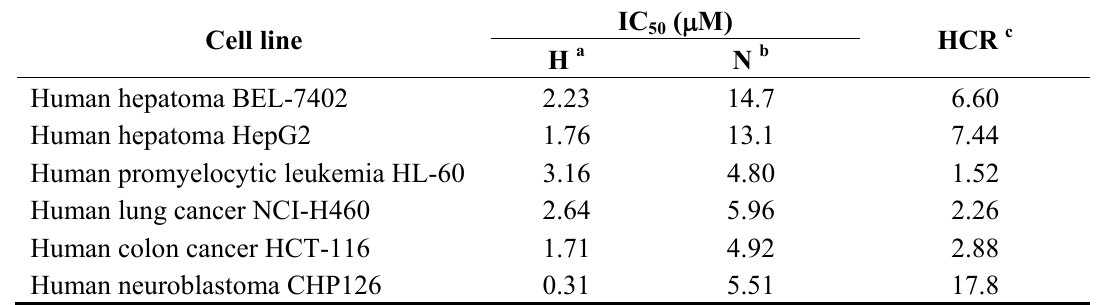
Table 2. Cytotoxic activity of 9h against six human cancer cell lines in hypoxia and in